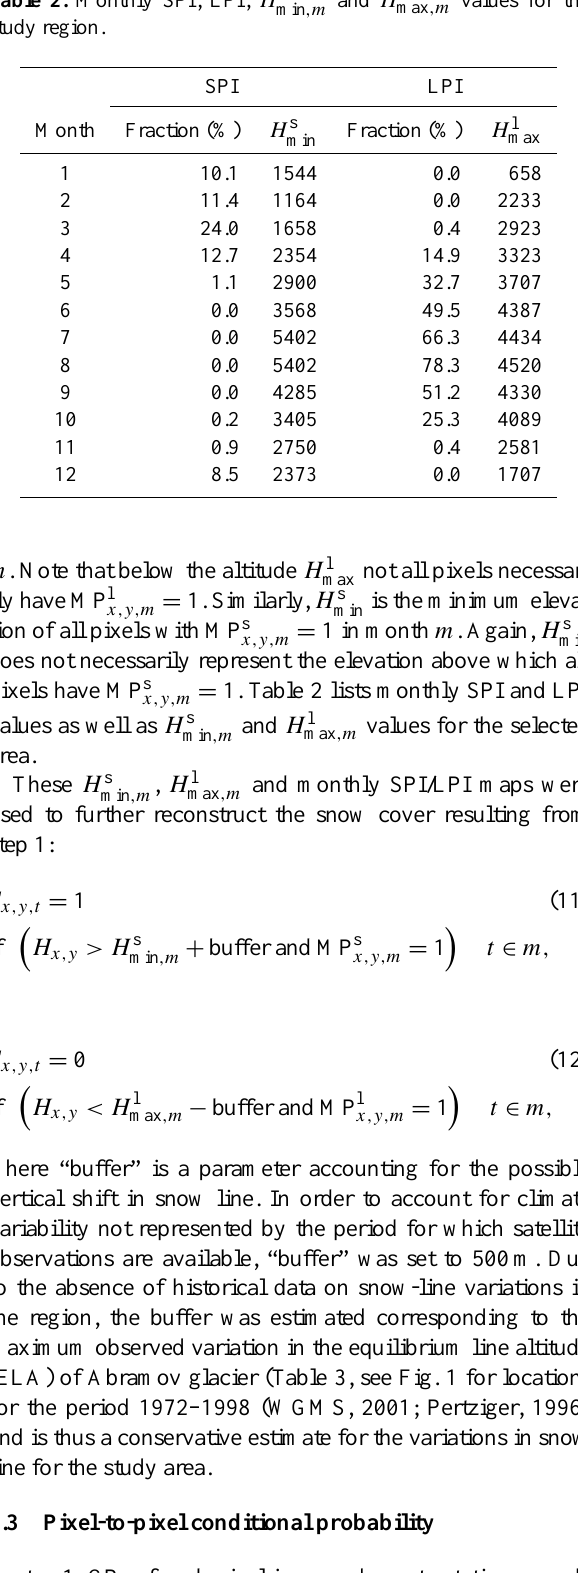
and H l max ,m values for the min ,m